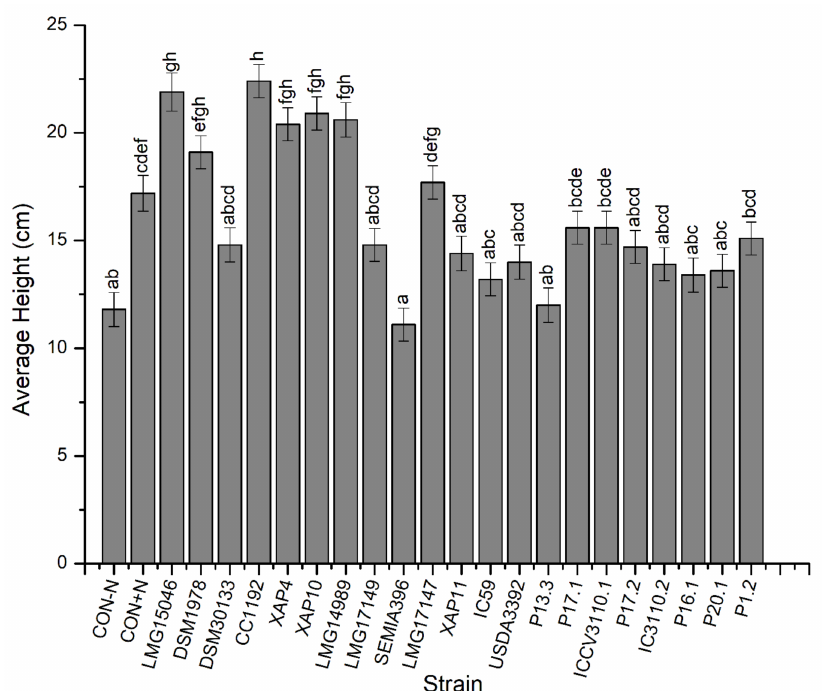
Figure 1. The effects of the Mesorhizobium isolates on the average height of chickpea plants. Bars are means ± standard errors, n = 3. Different letters (a–h) above the bars indicate treatments with significant differences ( p <